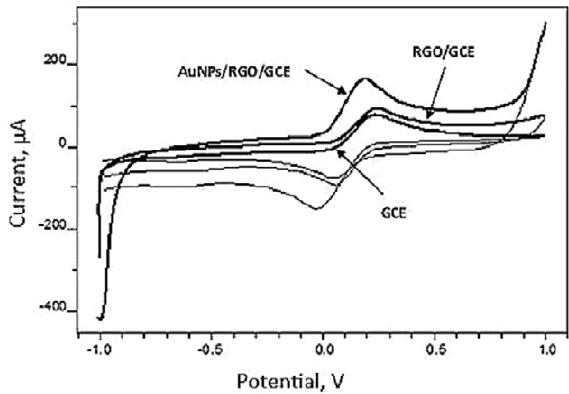
Figure 5. Cyclic voltammograms of GCE, RGO/GCE and AuNPs/ RGO/GCE in 5.0 mM [Fe(CN) 6 ] 3–/4– containing 100 mM KCl.